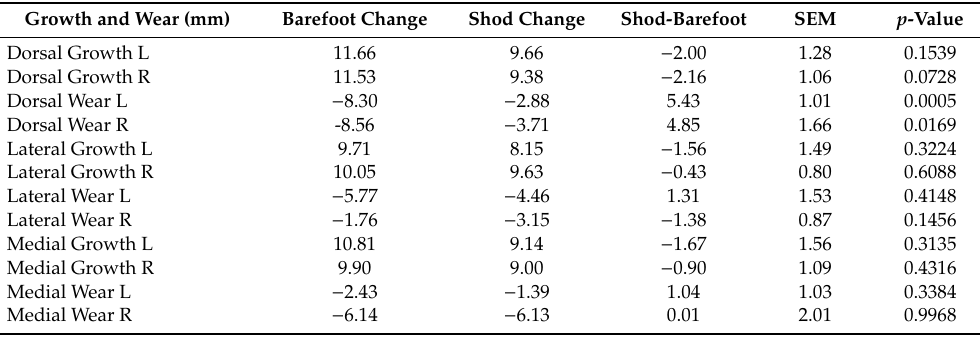
Table 3. Changes in hoof growth and wear of horses when barefoot and shod during a seven-week period. The results are displayed as the mean change when horses were barefoot ( n = 11) and shod ( n = 11), followed by the di ff erence between the two treatments and the standard error of the mean (SEM) di ff erence. Results are displayed for the left (L) and right (R) forelimbs. Growth and Wear